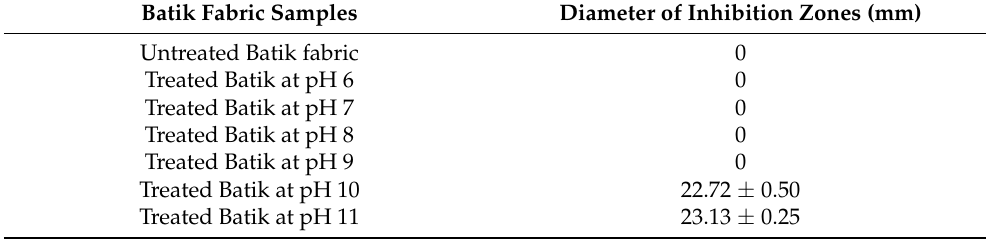
Table 2. The Inhibition Zone of the Batik Fabric Samples.